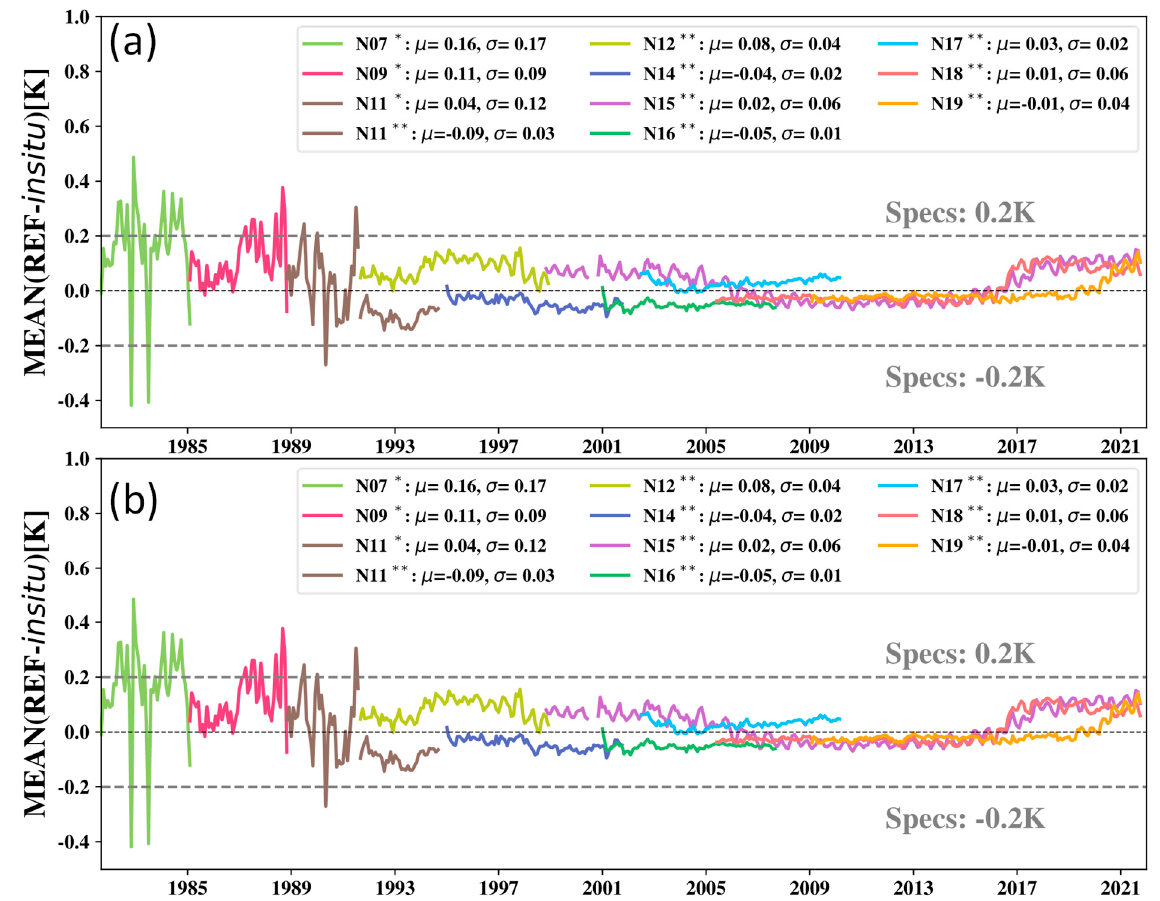
Figure 3. Monthly nighttime ( a ) biases, µ , and ( b ) SDs, σ , of Δ SST = ‘first guess’ − in situ SST. The inserts show mission-averaged means, µ ( µ ) and µ ( σ ), and corresponding SDs, σ ( µ ) and σ ( σ ). The single and double asterisks denote periods when different ‘first guess’ SSTs were used: (*) REF = CCI L4 and (**) REF = CMC L4 SST. Note that for N07 and N09, in situ = (S + D + TM), whereas for N11–N19, in situ = (D + TM).